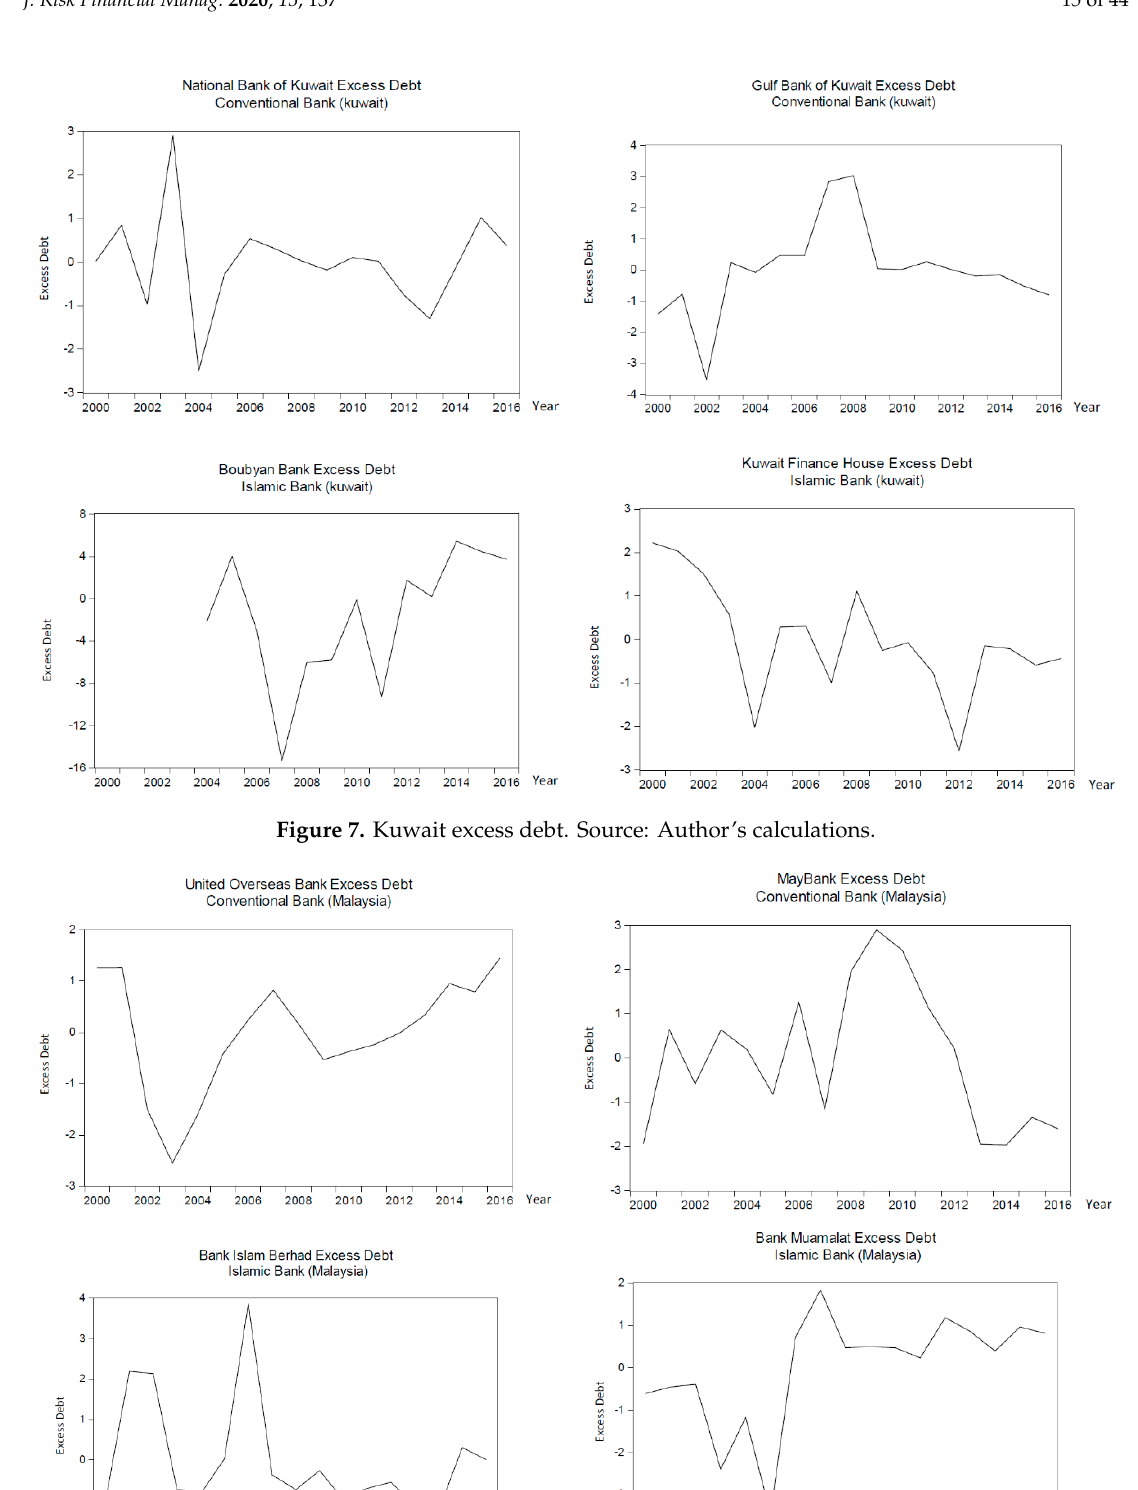
Figure 6. Bahrain excess debt. Source: Author’s calculations.